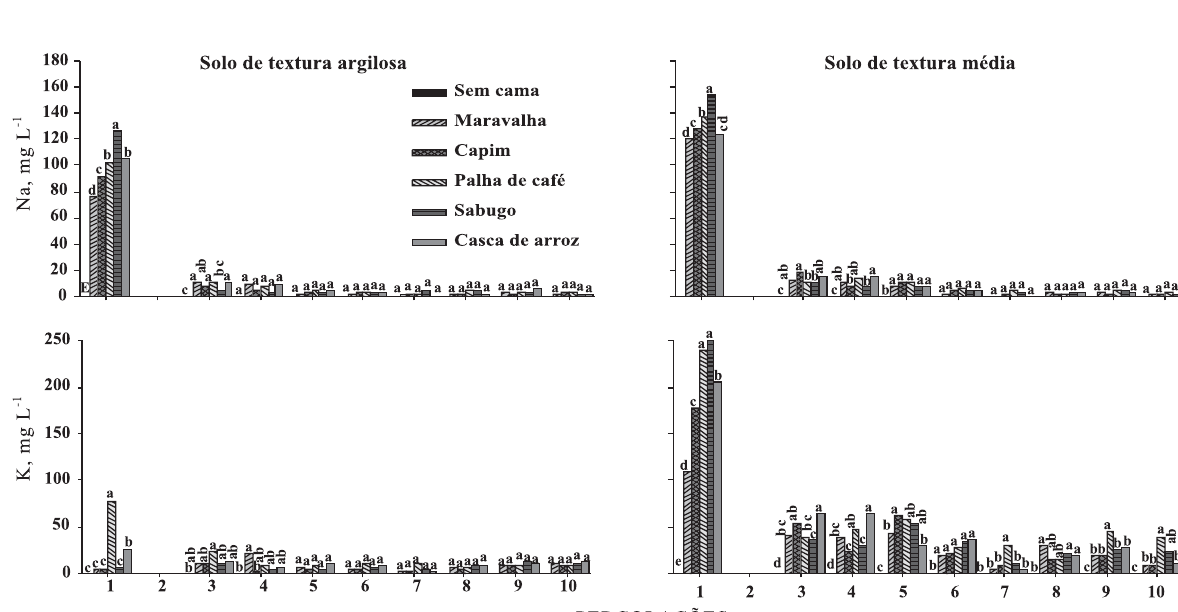
Figura 3. Concentrações de Na e K em percolados coletados sucessivamente, ao longo do tempo, em dois Latossolos de texturas distintas, que receberam 160 t ha -1 , base material seco, de cinco tipos diferentes de cama de aviário, no anel superior de colunas de percolação, comparados à testemunha, sem cama de aviário. As médias das concentrações dos elementos seguidas pela mesma letra em uma mesma percolação, para as diferentes camas, não diferiram entre si pelo teste de Tukey, a 5